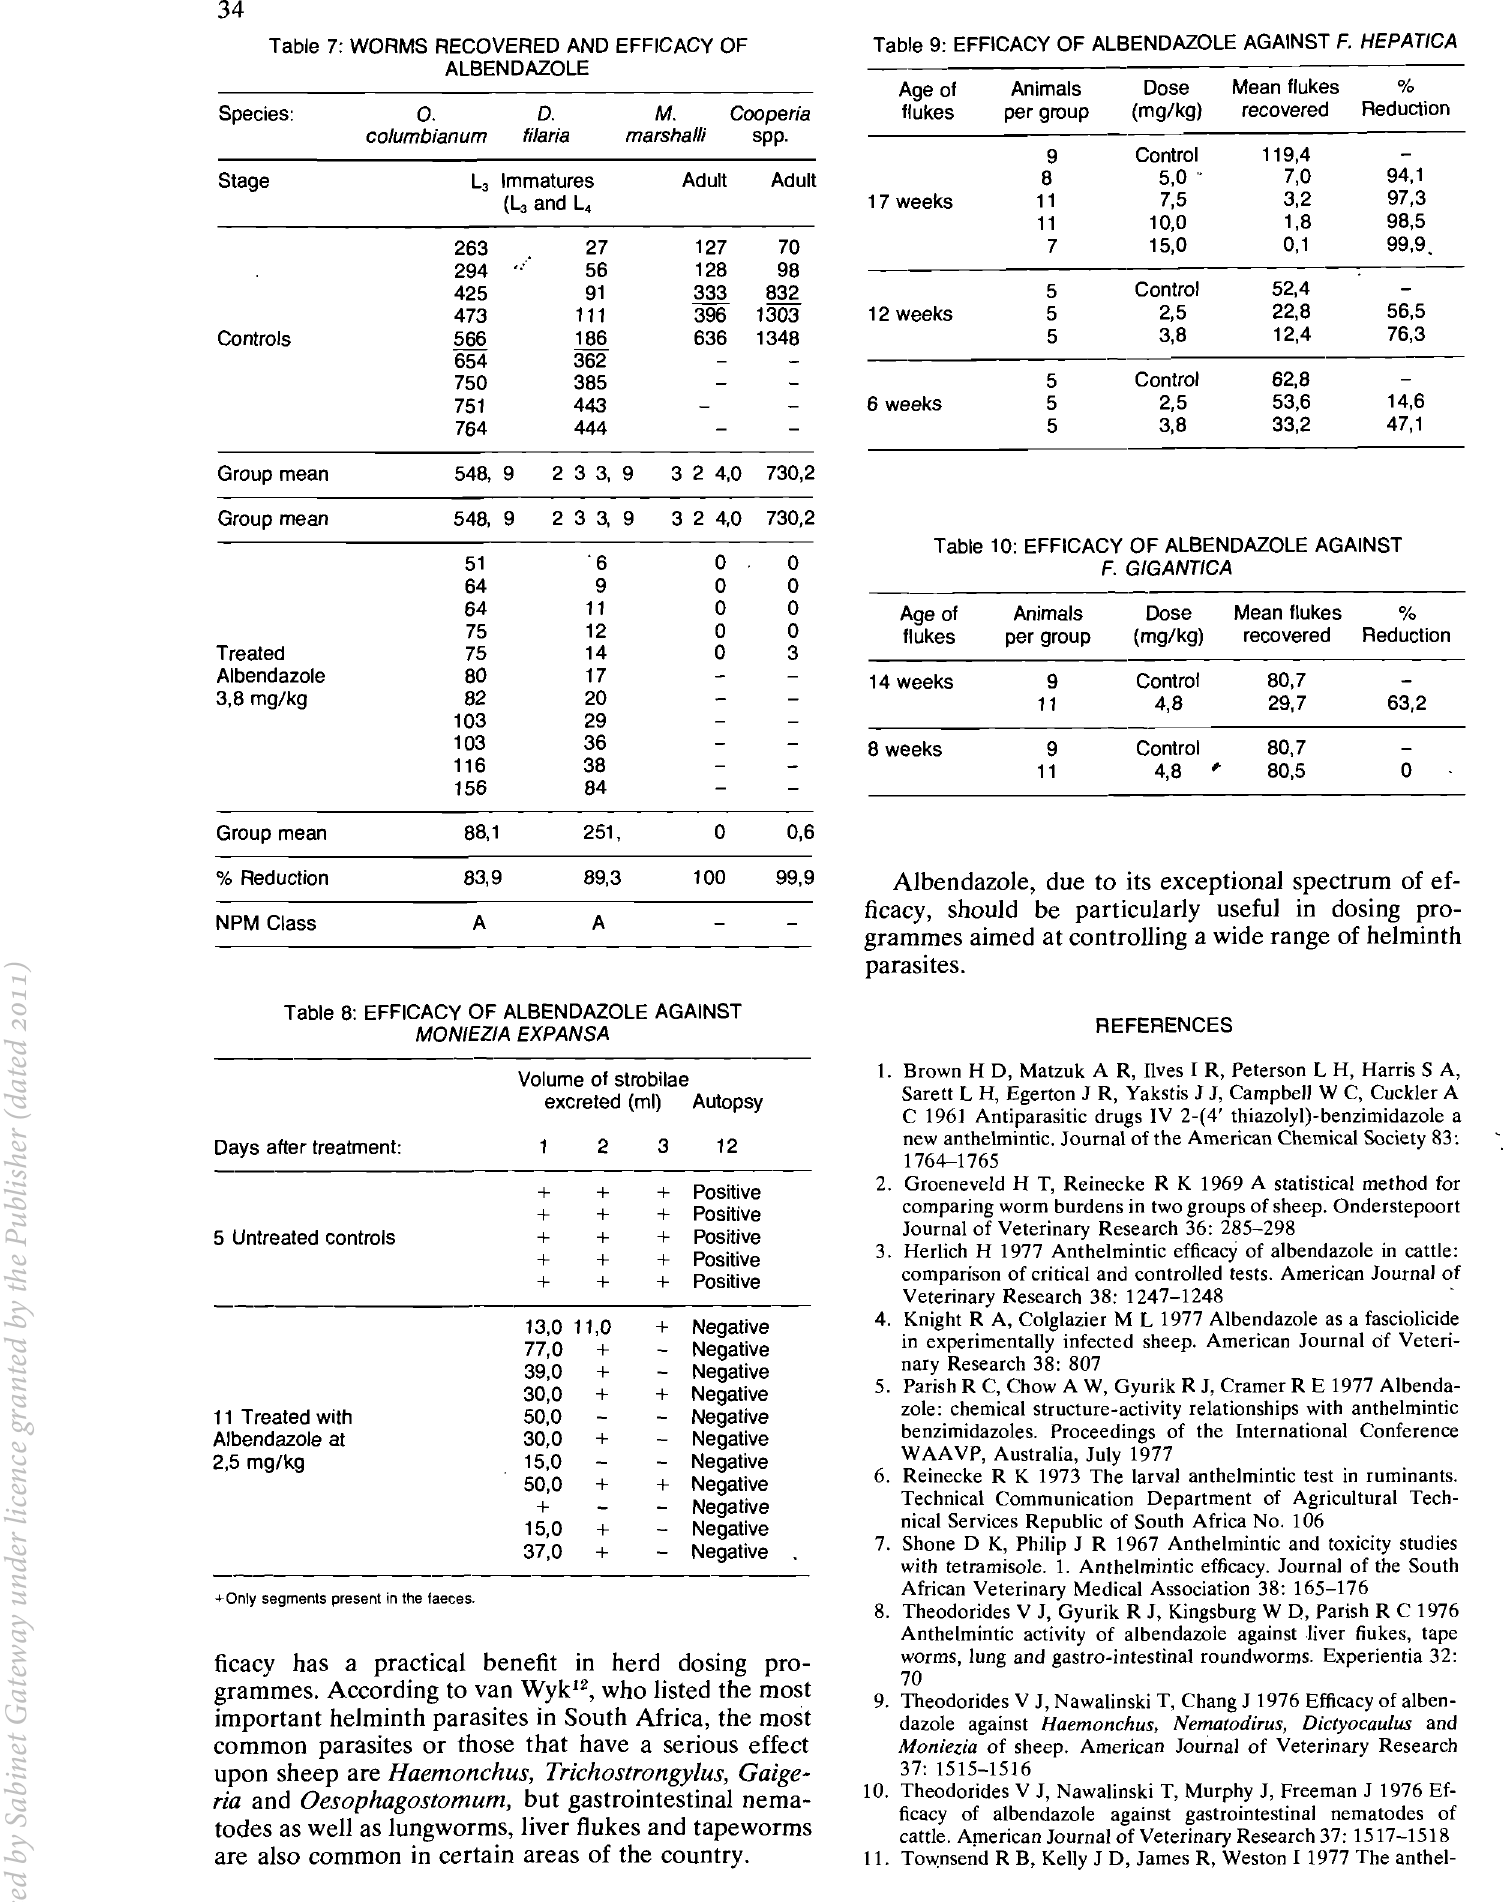
Table 7: WORMS RECOVERED AND EFFICACY OF ALBENDAZOLE Species: